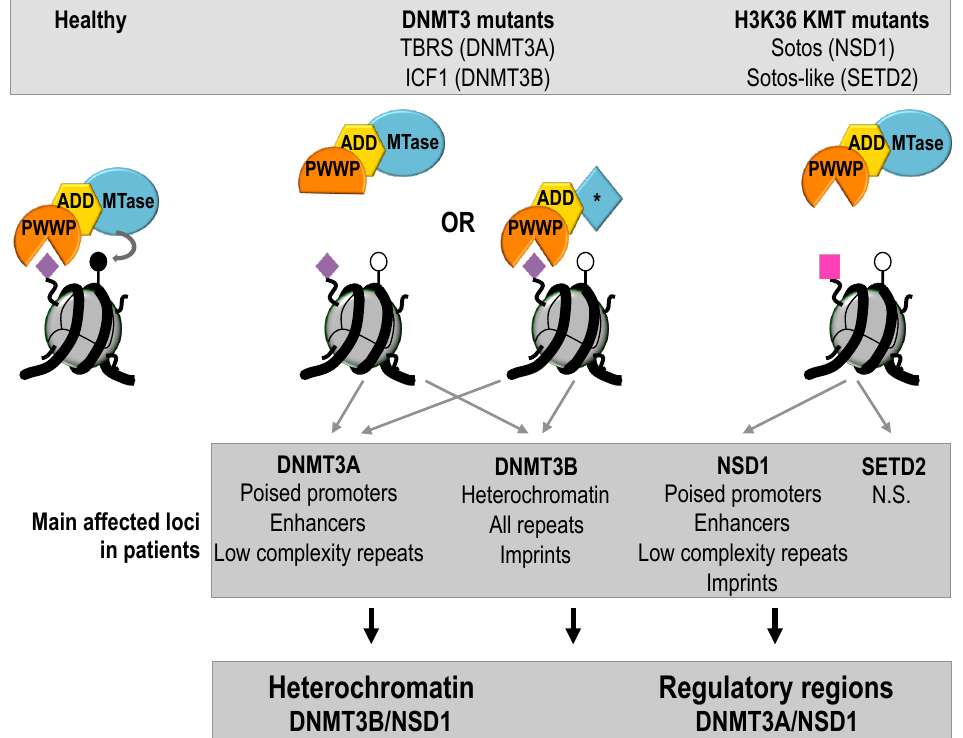
Figure 5. Crosstalk between DNMT3 enzymes and NSD1 seen through comparative analysis of patients methylomes. DNMT3 enzymes are represented in the form of their two regulatory domains PWWP and ADD, and their catalytic domain (MTase). We focus here on histone H3K36me2/me3 (purple diamond) catalyzed by NSD1 or SETD2 KMTs (not represented). DNMT3 mutations in patients can affect the PWWP domain, which can no longer recognize H3K36me2/me3, or the calatytic domain, both leading to reduced DNAme (white lollipop). Likewise, mutations in H3K36me3 KMTs lead to reduced methylation of H3K36 (pink square) and genome-wide DNAme alterations, probably through altered recruitment of DNMT3 enzymes at methylation sites. The main features of affected loci in each class of patients are listed, and intersected in broad classes of chromatin